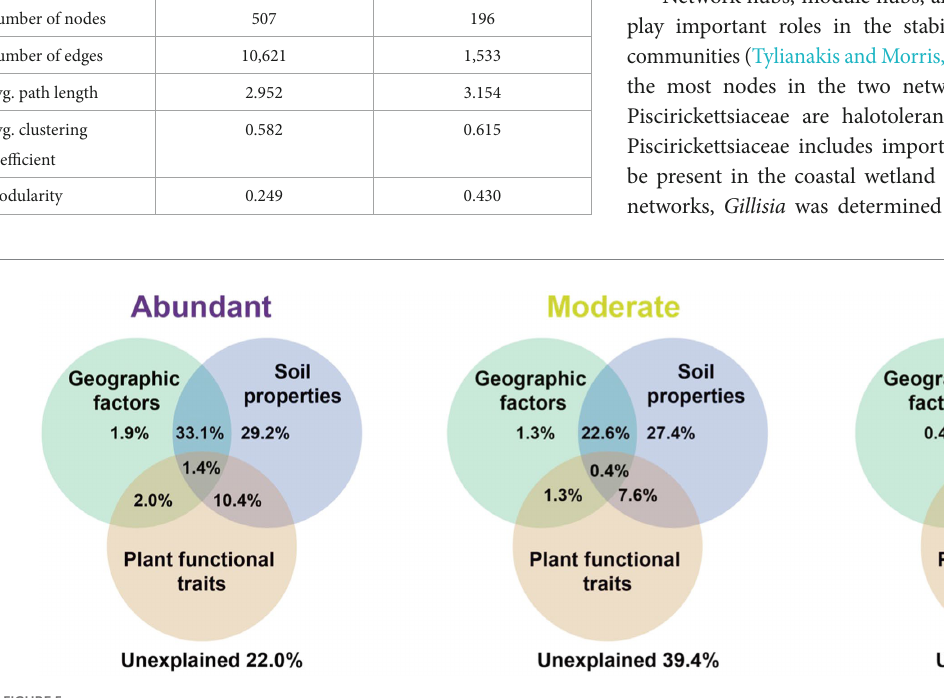
FIGURE 5 Variation partitioning analysis (VPA) showing the effect of geographic factors, plant functional traits, and soil properties variables on the community composition of the bacteria. Values indicate the percentage of variation explained by each